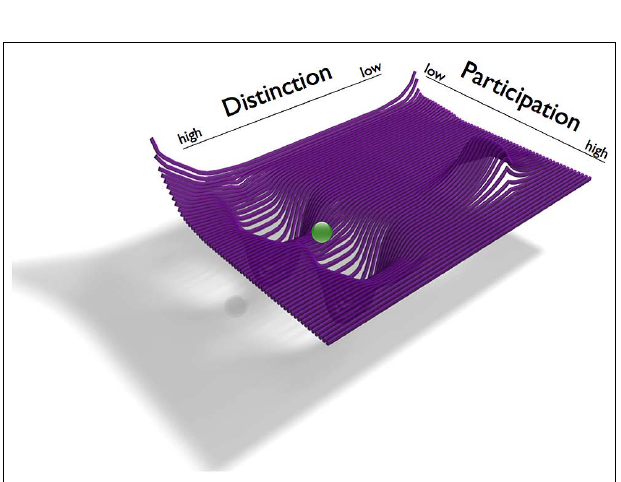
FIGURE 5 | Illustration of the phase spaces of the individuals in example 2 (left: “She”; right: “He”). The phase spaces are spanned by the dimensions of Distinction D and Participation P . Individual system states are